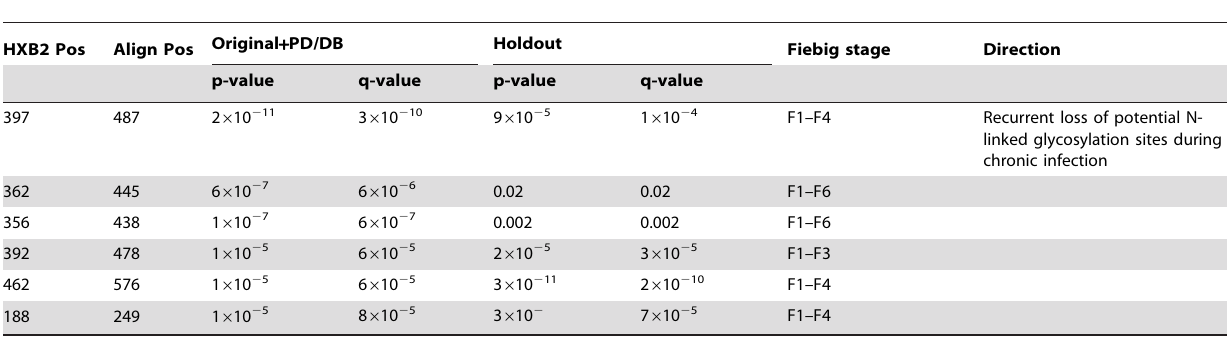
Table 5. Summary statistics using the combined original and PD/DB sets and holdout set to the gain or loss of PNLGs, defined as the motif NX[ST], where N is Asp, X is any amino acid besides Pro, and [ST] is a Ser or Thr.